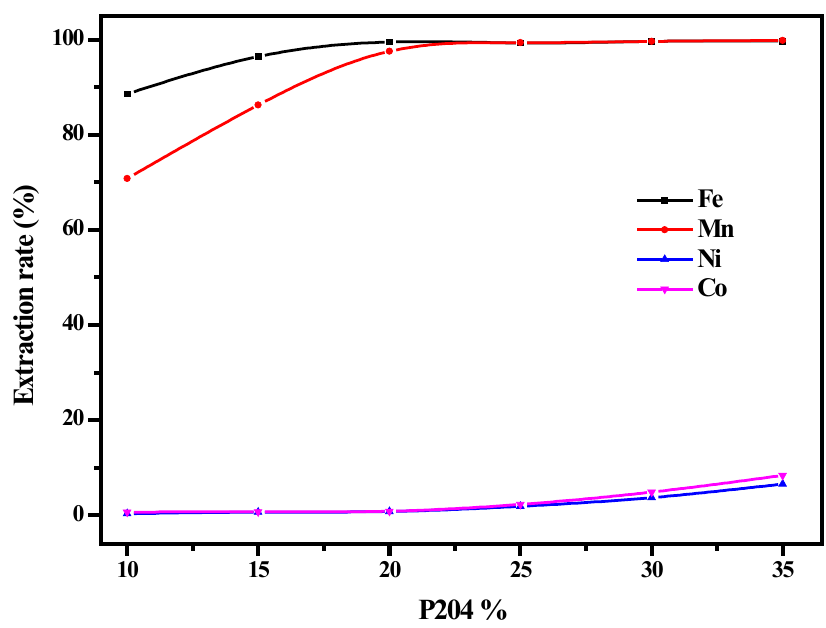
Figure 8. Effect of P204 concentration on the extraction efficiency of Fe and Mn.